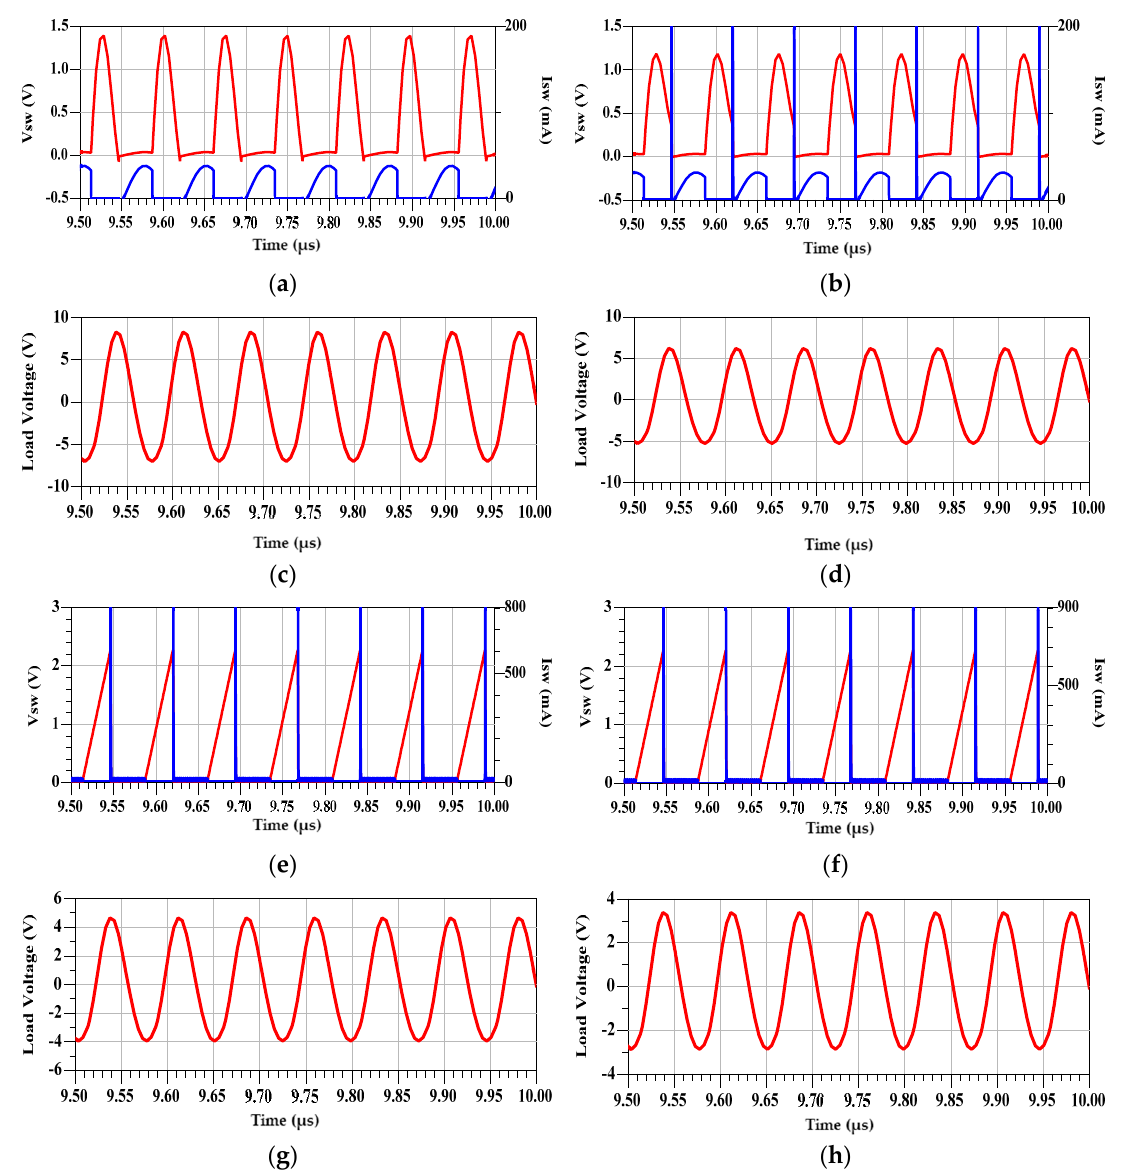
Figure 9. Switch voltage (red line) and current (blue line) of PA for different coupling capacitances: ( a ) V sw and I sw at C eq = 0.4 pF; ( b ) V sw and I sw at C eq = 0.3 pF; ( c ) Load Voltage at C eq = 0.4 pF; ( d ) load voltage at C eq = 0.3 pF; ( e ) V sw and I sw at C eq = 0.2 pF; ( f ) V sw and I sw at C eq = 0.1 pF; ( g ) Load Voltage at C eq = 0.2 pF; and ( h ) Load Voltage at C eq = 0.1 pF.